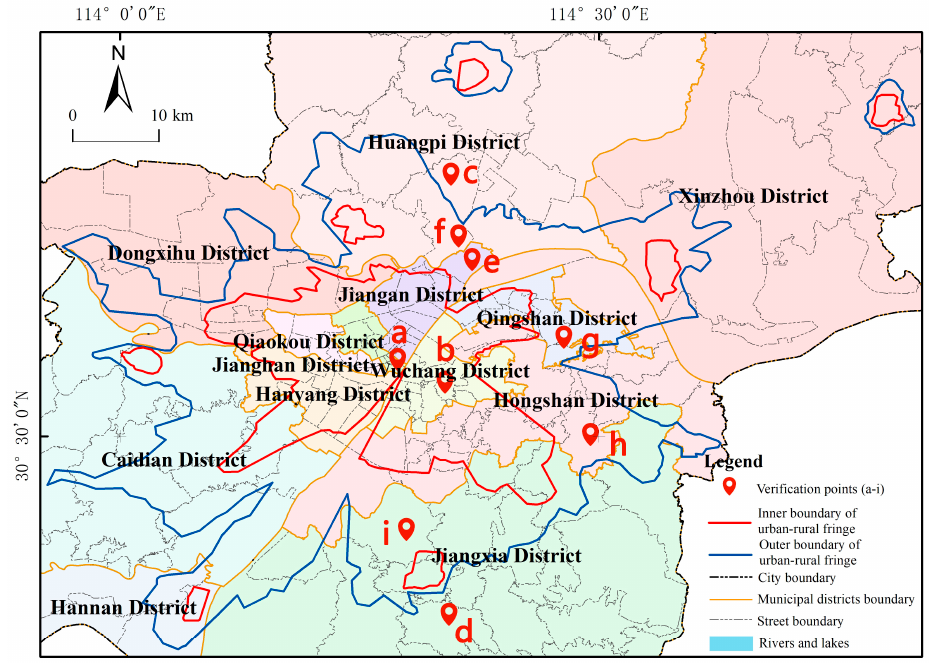
Figure 10. Distribution Map of Site Investigation Points Wuhan City.